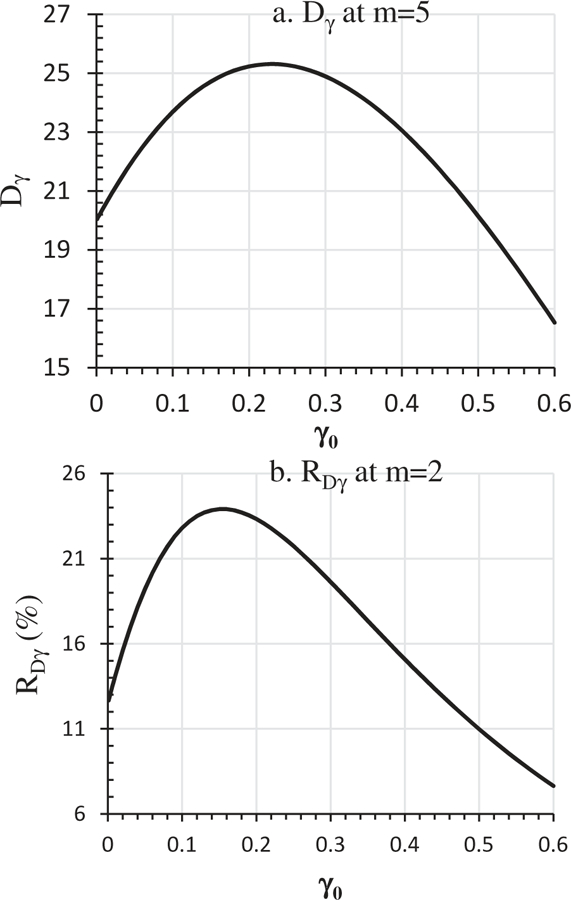
Effects of γ0 levels onDγ as defined by Equation (15) and RDγ as defined by Equation (16): a. Dγ at m = 5; b. Dγ at m = 2.